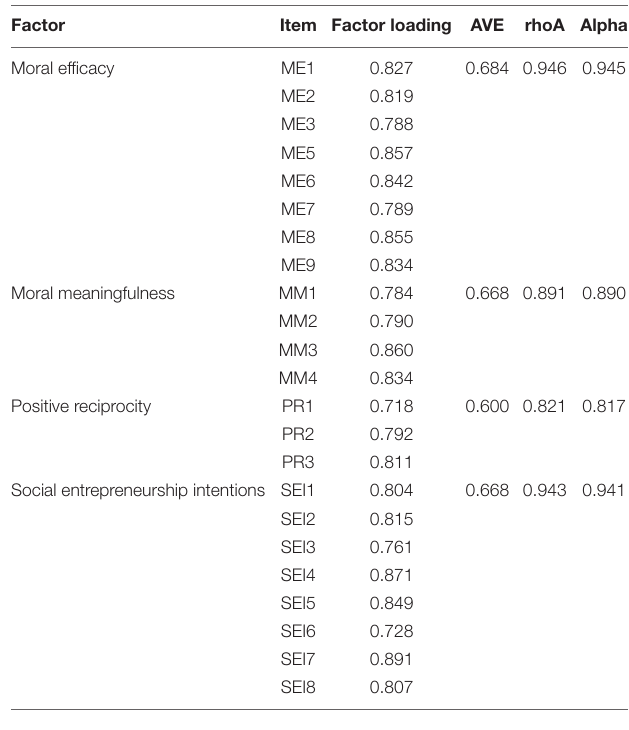
TABLE 3 | Inner VIF